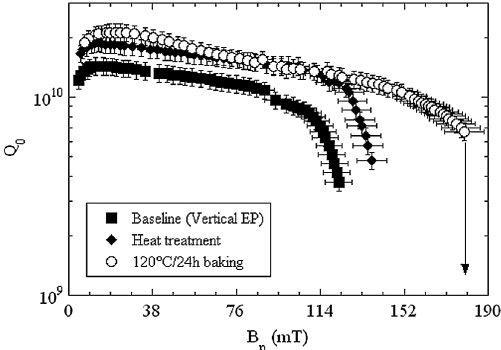
FIG. 17. Q vs B measured at 2.0 K on the fine-grain ILC p 0 single-cell cavity ‘‘AES001’’ after the baseline test (squares) and after the heat treatment (triangles) at 800 (cid:1) C = 3 h , 400 (cid:1) C = 20 min . The round symbols are the data after additional in situ baking at 120 (cid:1) C for 24